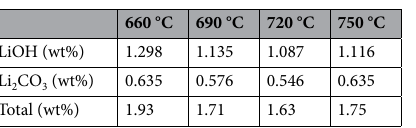
Table 3. Titration results of residual LiOH and Li 2 CO 3 of NCA with various sintering